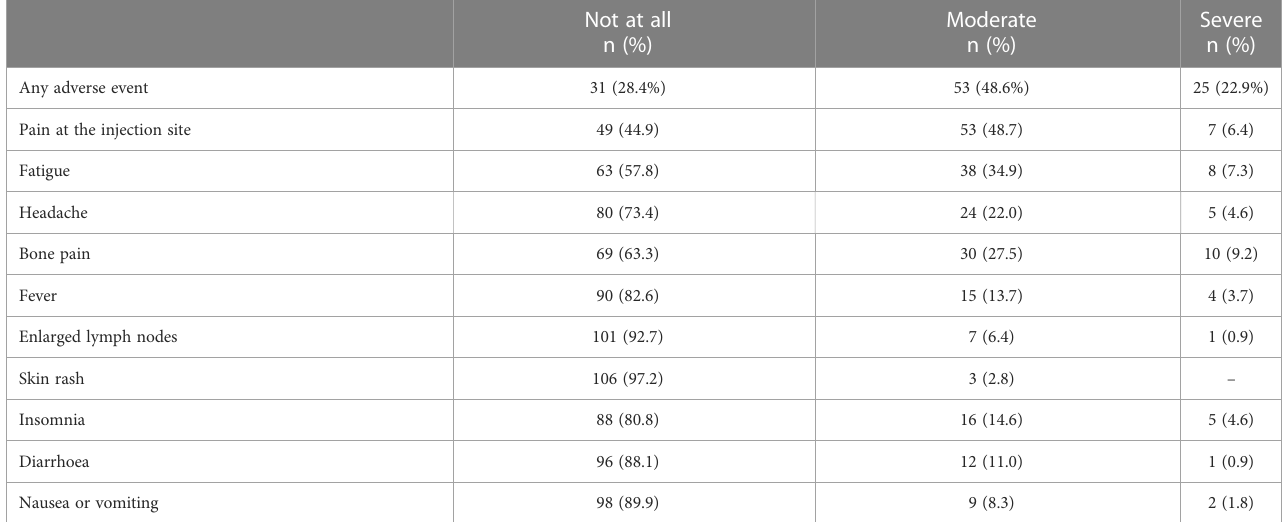
TABLE 2 Vaccine-related reactions at one week after the fourth dose (n=109).